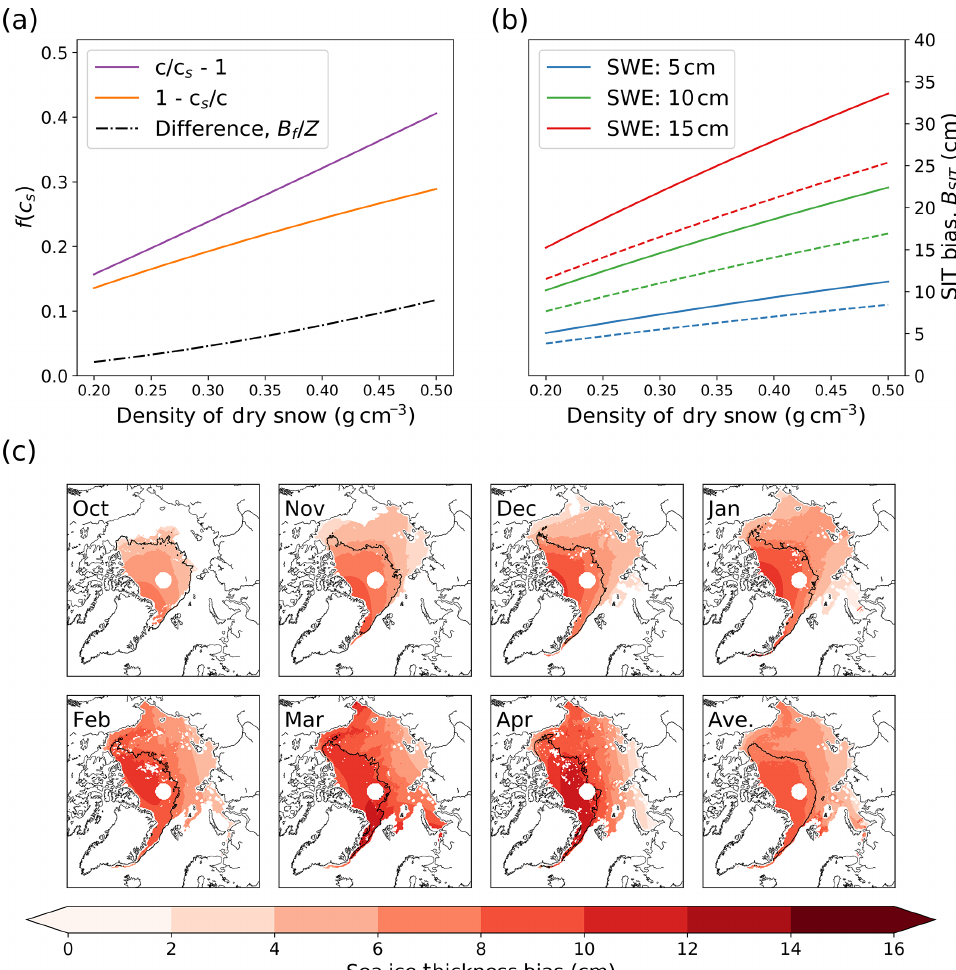
Figure 1. (a) Difference between conventional use of Eqs. (6) and (5) as a function of snow density. This bias increases with snow density, ultimately exceeding a factor of 0.1 of the snow depth for dense snow. (b) Sea ice thickness bias for a fixed mass of snow increases as it densifies and contracts with time. Solid lines indicate bias for first-year ice, dashed lines for multi-year ice assuming fixed densities of 916.7 and 882kgm − 3 respectively. (c) Monthly thickness bias introduced by conventional and erroneous use of Eq. (6) when calculated using W99 density and depth distributions. Pixels are only displayed where sea ice type is known in all years 2010–2018. Black line indicates region where multi-year ice is present in over 50% of years. Monthly averages derived from the years